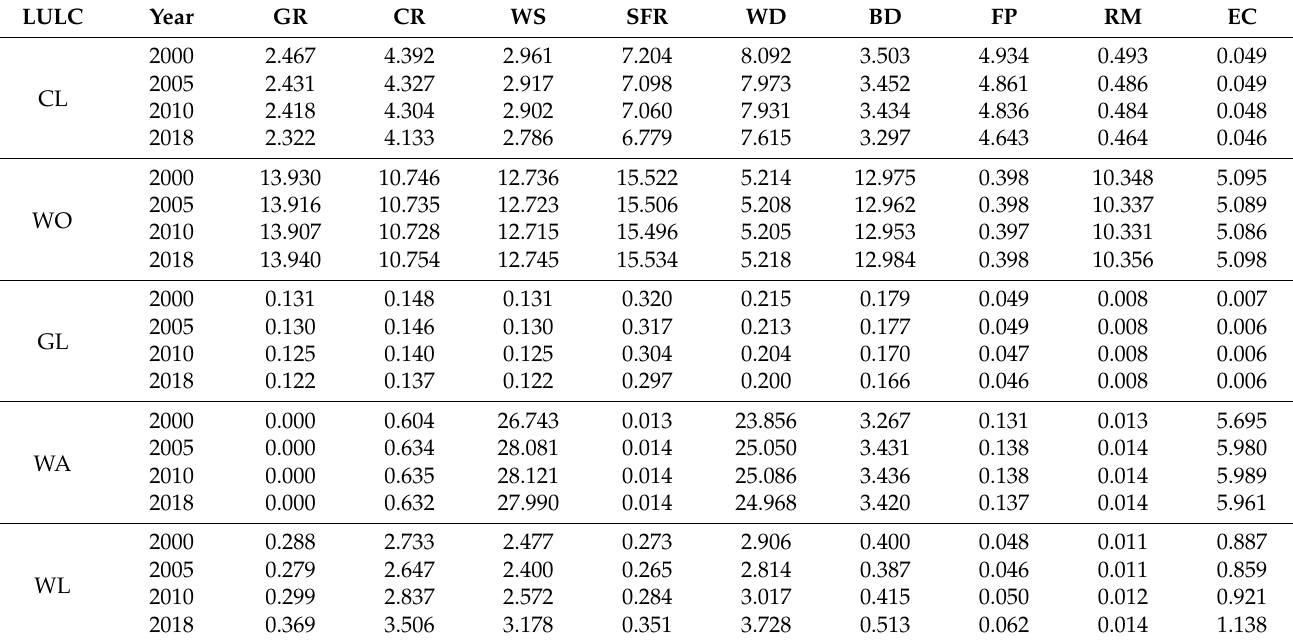
Table 2. The ESVs of various service functions of different ecosystems of the Dongting Lake in 2000, 2005, 2010 and 2018 (billion